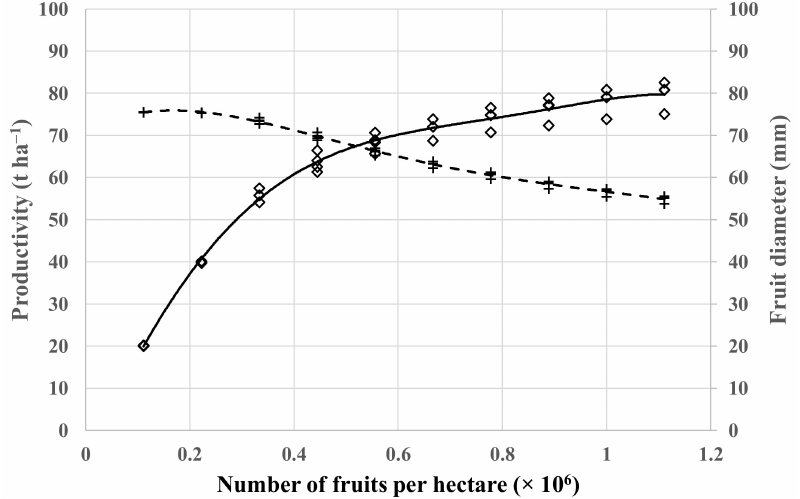
Figure 5. Example of simulated productivity ( ♦ ) and fruit diameter ( + ) in relation to crop load in an apple orchard. The site is in Acipreste, the trees are five years old at the beginning of the hydrological year, and the parameters are actual parameters measured in the orchard. The lines show polynomial fits to the simulated points.